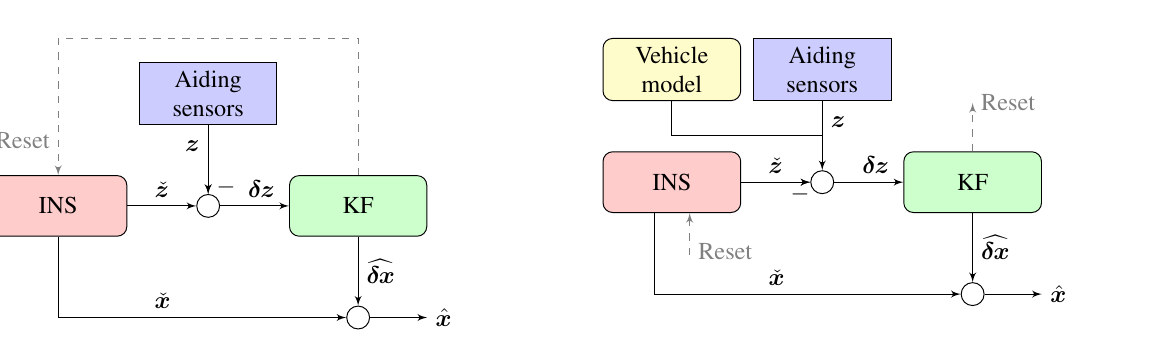
Figure 1: High-level outline if traditional aided INS. mented in software. The navigation equations take the gyro and accelerometer measurements from the IMU as inputs and integrate them to velocity, position and orientation. The general solution of the navigation equa- tions does not require any information on the dynamics of the vehicle in which the IMU is installed.